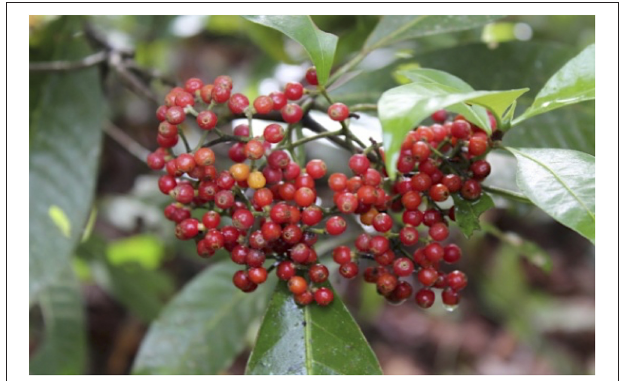
FIGURE 1 | An image of P. viridiflora